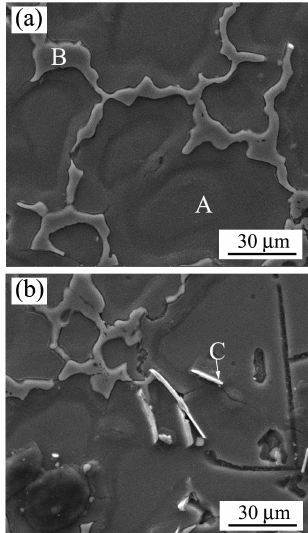
Figure 2. Scanning electron micrographs of as-cast AZ91D+0.75Ce alloy: ( a ) Matrix phase and grain boundary; ( b ) needle-like phase. 126